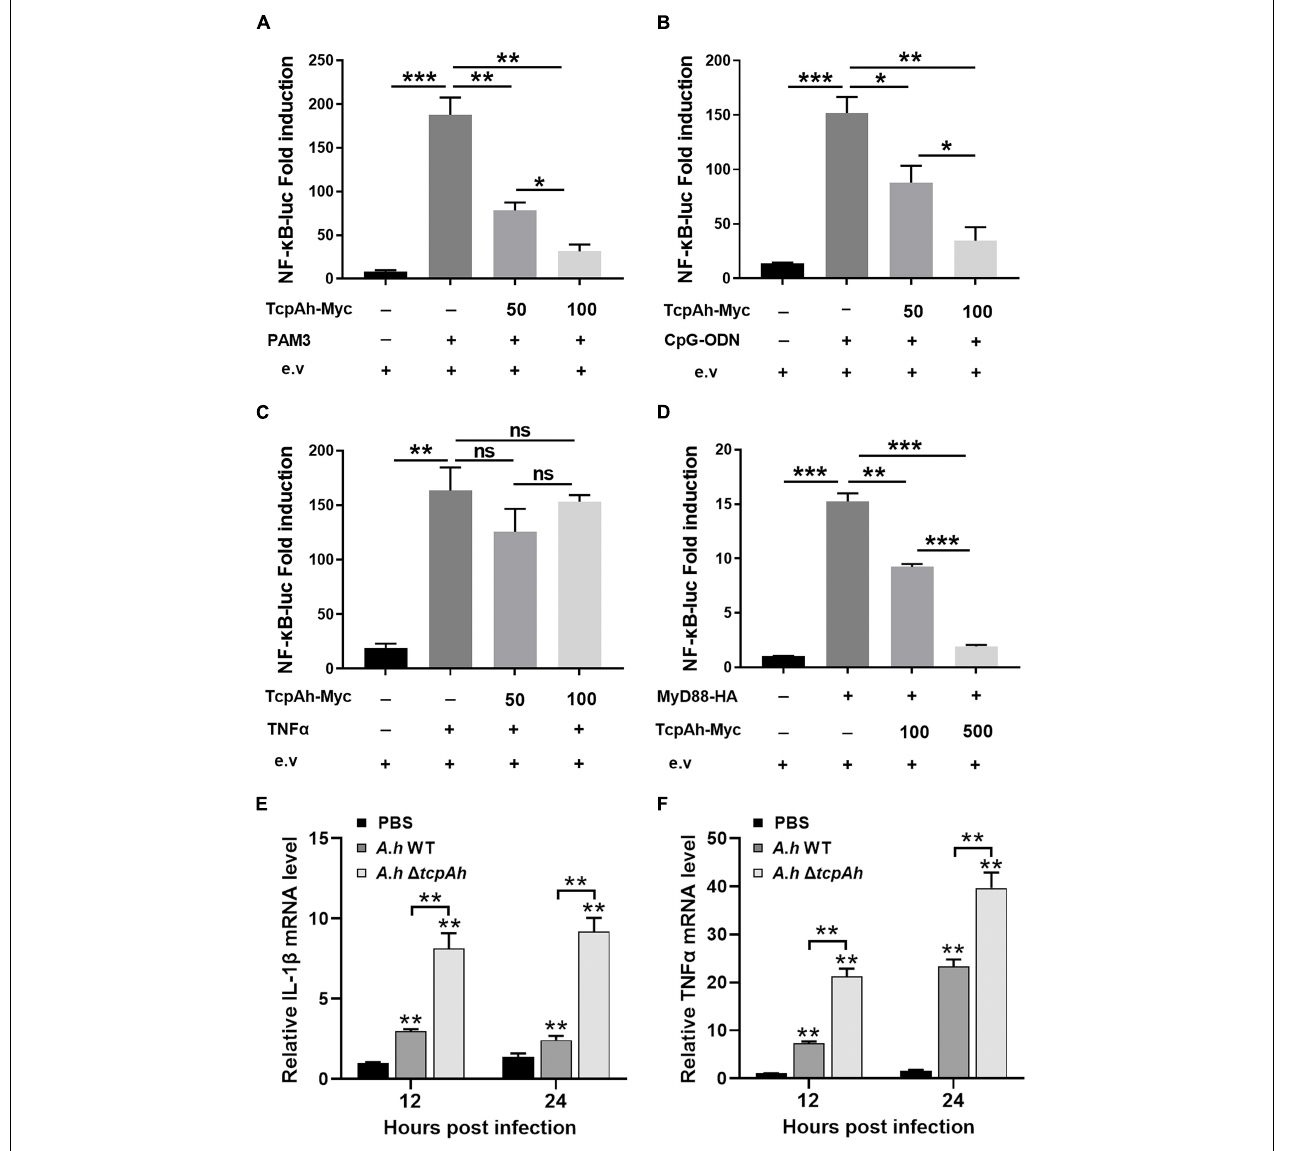
FIGURE 3 | Examination of the inhibitory role of TcpAh in MyD88 signaling pathway. (A–C) Activation of the NF- κ B-binding promoters detected in zebrafish embryos microinjected with NF- κ B luciferase reporter (NF- κ B-Luc; 100 pg/embryo), renilla luciferase reporter (10 pg/embryo), and increasing amounts (0, 50, and 100 pg/embryo) of TcpAh expression vectors with stimulation of (A) Pam3CSK4 (200 pg/embryo), (B) CpG-ODN (400 pg/embryo), and (C) TNF α (10 pg/embryo) for 12 h. Data are the average luciferase activity ± SD (* p < 0.05; ** p < 0.01; *** p < 0.001; ns, not significant). (D) Activation of the NF- κ B-binding promoter detected in HEK293T cells transfected with NF- κ B luciferase reporter (NF- κ B-Luc; 150 ng/mL), renilla luciferase reporter (15 ng/mL), MyD88 expression vector (50 ng/mL), and increasing amounts (0, 100, and 500 ng/mL) of TcpAh expression vectors. Data are the average luciferase activity ± SD (** p < 0.01; *** p < 0.001). (E,F) Real-time PCR analysis for the expression of zebrafish IL-1 β (E) and TNF α (F) in leukocytes, which were sorted from peripheral blood, spleen, and kidney tissues at indicated time after i.p. stimulation with PBS, wild-type A. hydrophila and (cid:49) tcpAh mutant. Data are representative of three independent experiments as mean ± SD (** p < 0.01). Standard loading was indicated by β -actin